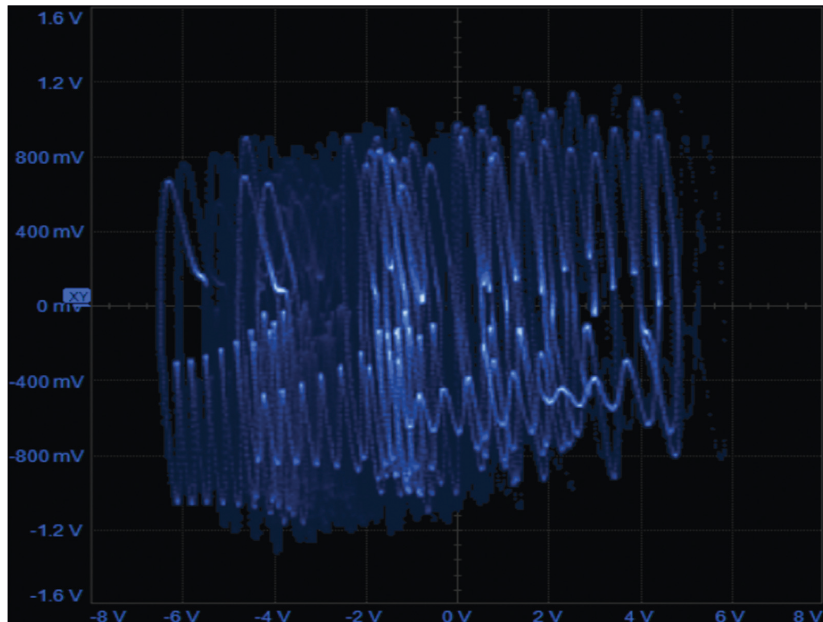
Figure 38: Experimental hyperchaotic attractor of the proposed model (1) in the ( z